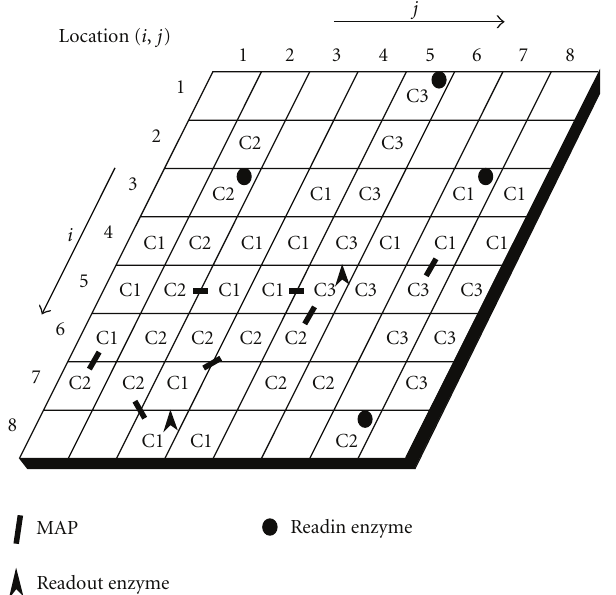
Figure 1: Structure of cytoskeletal